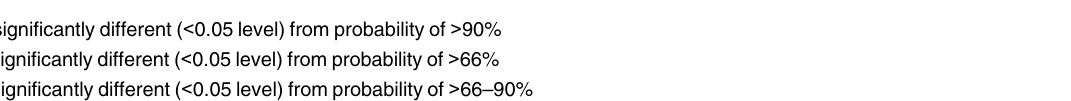
Table 5. Thermal stressfor reefs with different bleaching probabilities. Annual maximum DHW (˚C-weeks) All reefs > 90% > 66% > 66–90% > 50–66% Area-weighted 1.71 Median < 0.01 * significantly different ( < 0.05 level) from probability of > 90% + significantly different ( < 0.05 level) from probability of > 66% ^ significantly different ( < 0.05 level) from probability of >